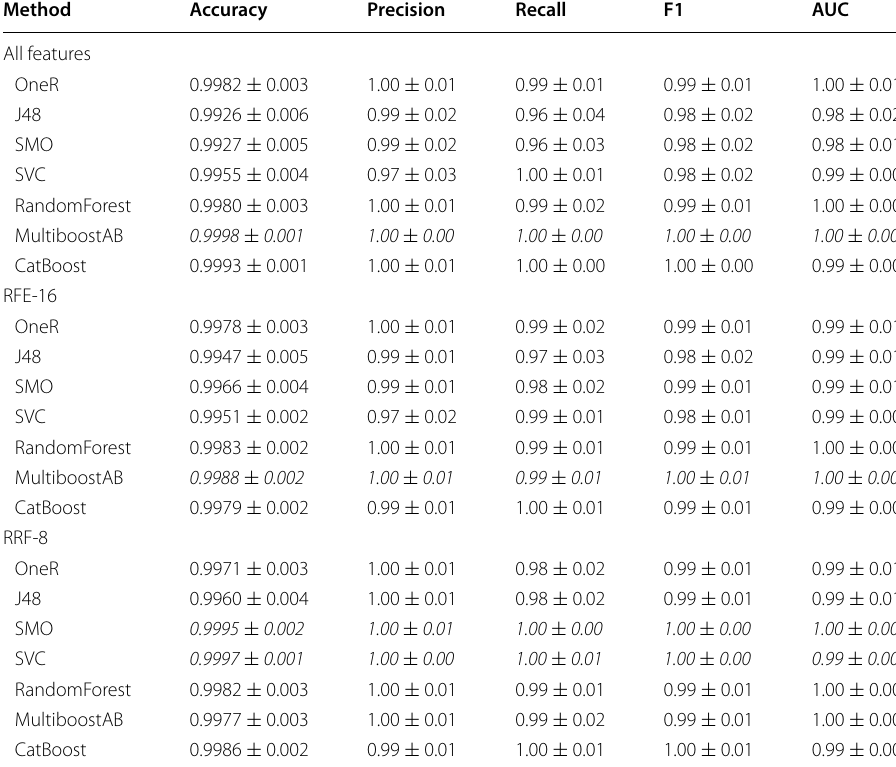
Table 16 From [23] original caption, “Iris recognition performances on the CASIA dataset, with the cross-validation performed after the over-sampling